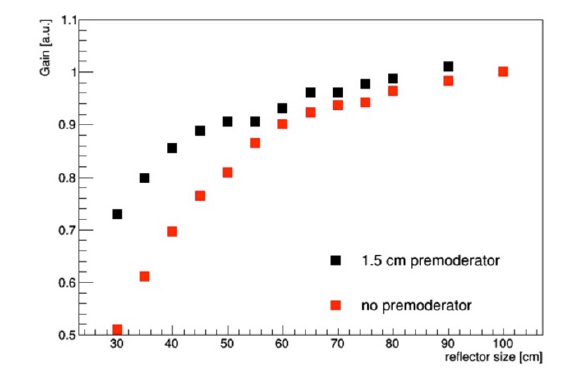
Fig. 8. Dependence of the source cold brightness on the size of Be reflector, with and without water